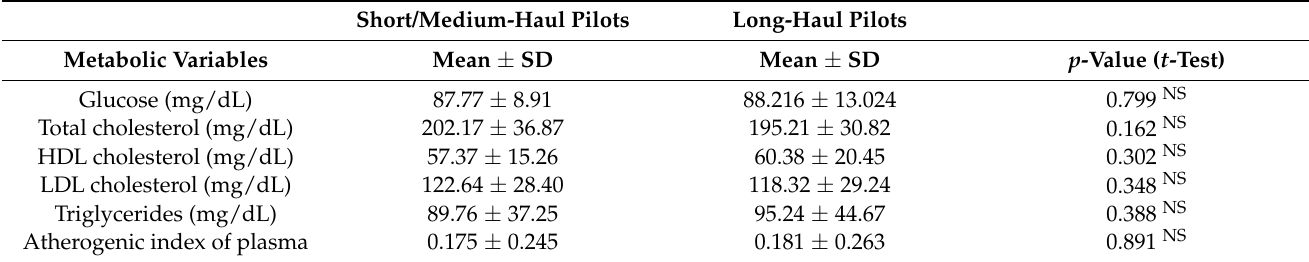
Table 2. Metabolic profile according to flight